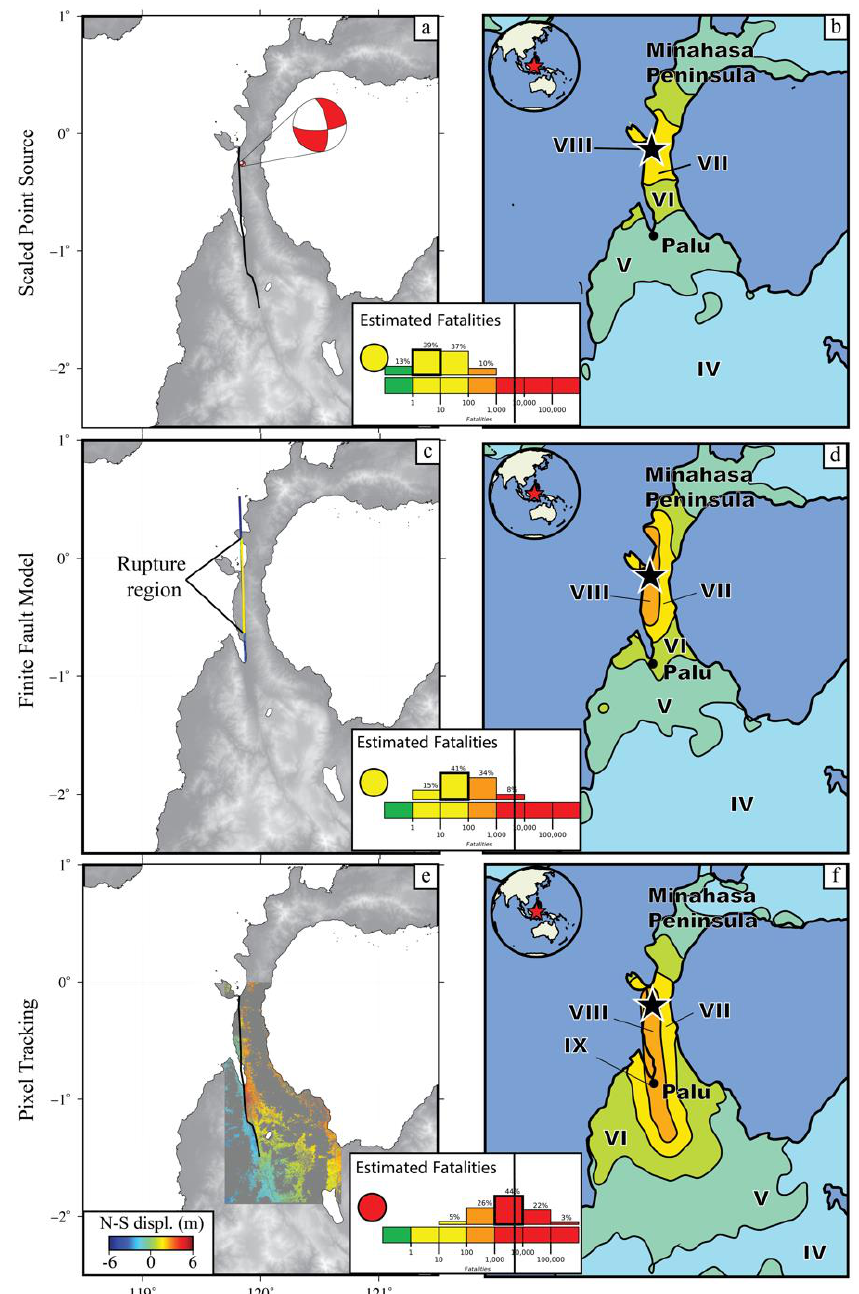
Figure 5. Examples of the evolution of NEIC PAGER reports following the 2018 Palu, Indonesia earthquake. ( a , b ) Initial earthquake location and W-phase moment tensor solution with the corresponding PAGER report that used a scaled point source solution. The black line indicates the earthquake rupture trace derived later from geodetic observations. ( c , d ) Preliminary teleseismic finite fault model and corresponding PAGER report. The region of primary co-seismic slip in the model is highlighted for spatial reference. ( e , f ) Sentinel-2 pixel tracking results (north-south displacement) with the interpreted rupture trace shown in black, and the corresponding PAGER report informed by the pixel tracking results. All PAGER reports additionally show the estimated fatality ranges and alert level (yellow and red) associated with each of the reports. The vertical black bars in the fatalities panels indicate the approximate total number of fatalities (~4,000 as of May 2019). Roman numerals indicate the expected MMI shaking intensities.